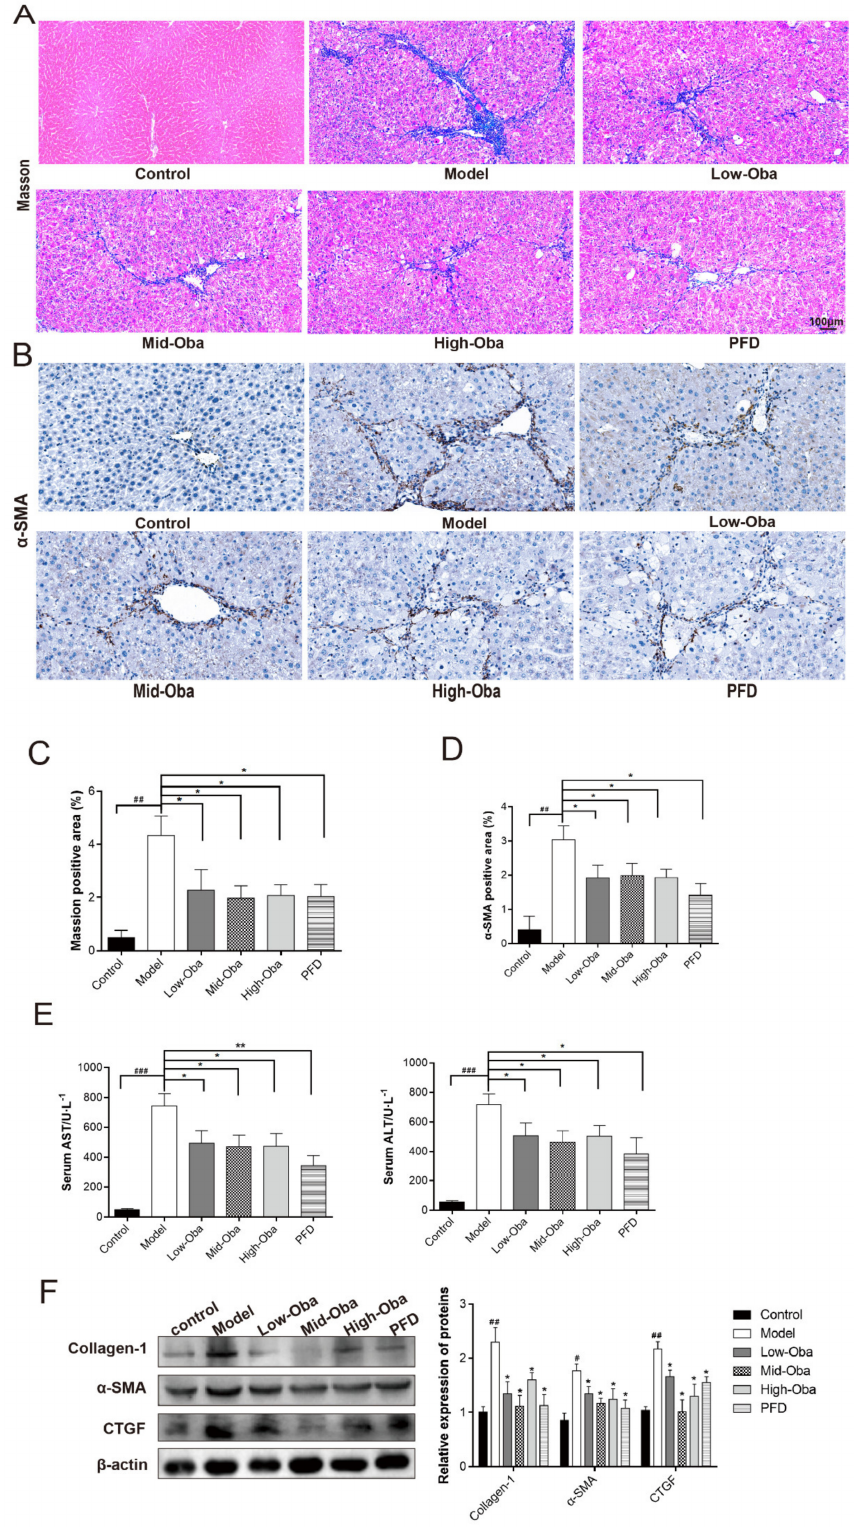
Figure 4. Oba attenuates CCl4-induced mouse liver fibrosis. ( A ) Masson staining of liver. ( B ) Immunohistologic staining for α -SMA (brown) in liver tissue. ( C ) Statistics of Masson positive areas. ( D ) Statistics of α -SMA positive areas. ( E ) Levels of serum aspartate transaminase (AST) and alanine transaminase (ALT). ( F ) Quantifications of Collagen-1, CTGF, α -SMA protein expression was assessed by Western blots from the mice in-vivo models. The results were expressed as means ± SEM ( n ≥ 3). # , ## , ### indicate p < 0.05, p < 0.01, p < 0.001 compare with control group; ns, *, ** indicate p > 0.05, p < 0.05, p < 0.01 compare with model